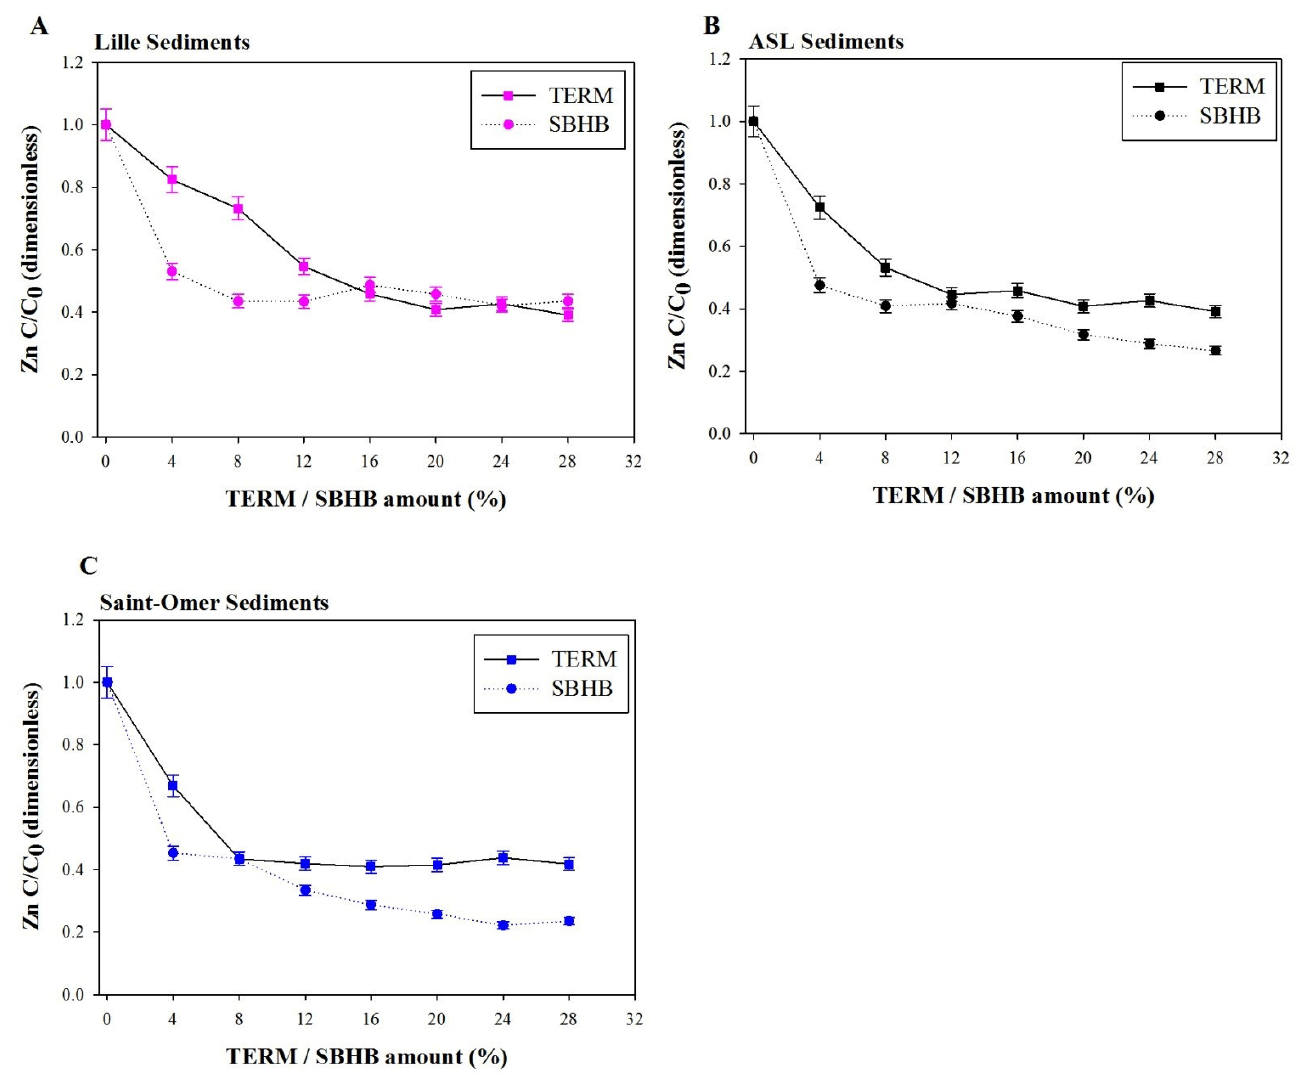
Figure 5. Evolution of Zn concentration ratios (C/C 0 ) within the studied sediments as a function of stabilizers amount (sequential addition). TERM: Thermo-Evolved Red Mud; SBHB: Slag Based Hydraulic Binder.